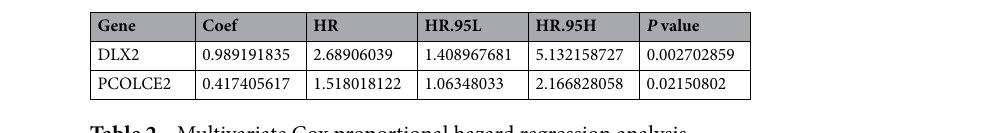
Table 2. Multivariate Cox proportional hazard regression